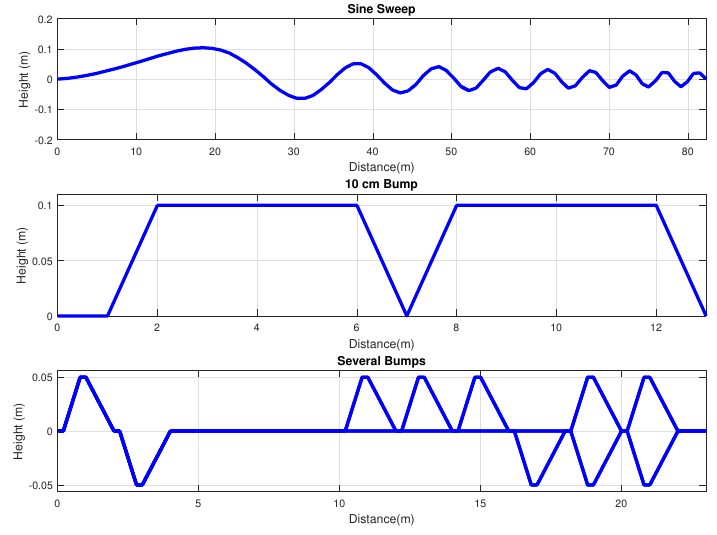
Figure 10. Road distortions.